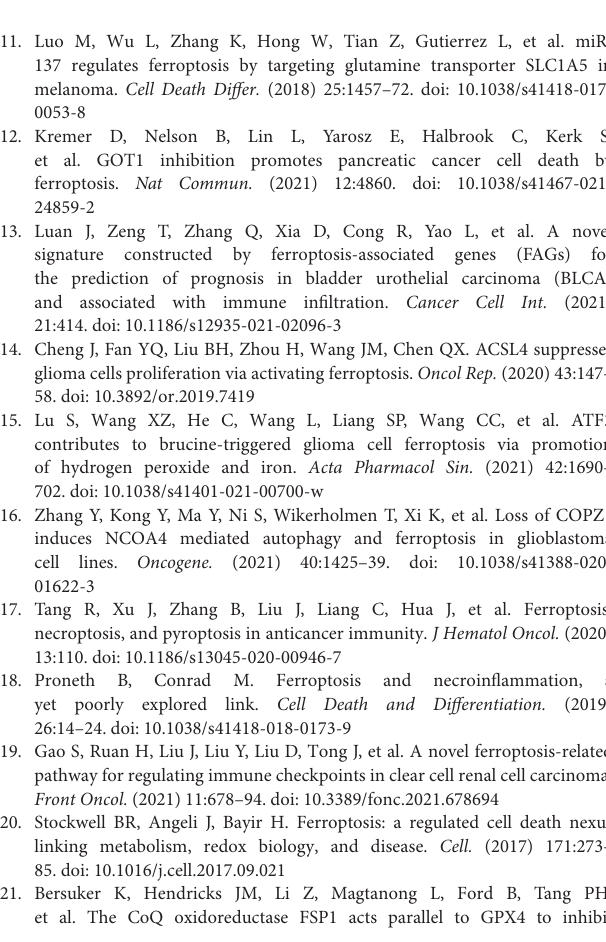
Supplementary Table 1 | FRGs and classification. Supplementary Table 2 | Primer sequences for qRT-PCR. Supplementary Table 3 | Clinical characteristics of patient cohort. Supplementary Table 4 | Eligible genes in the